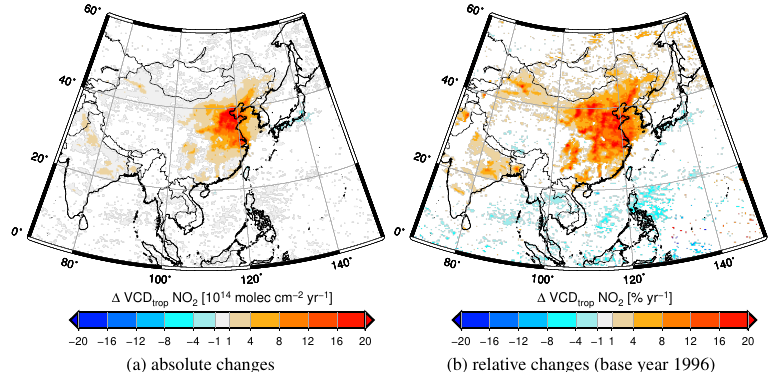
Fig. 16 : Annual change in VCD trop NO 2 over China derived from the levelshift trend model Fig. 14. Annual change in VCD trop NO 2 over China derived from the level shift trend model for the years 1996–2011. The maps show the for the years 1996-2011. The maps show the significant values of the linear trend component ω statistically significant values of the linear trend component ω from the level shift model (Eq. 3) in absolute values (a) and relative changes from the levelshift model (Eq. 3) in absolute values (left) and relative changes (right). (b)